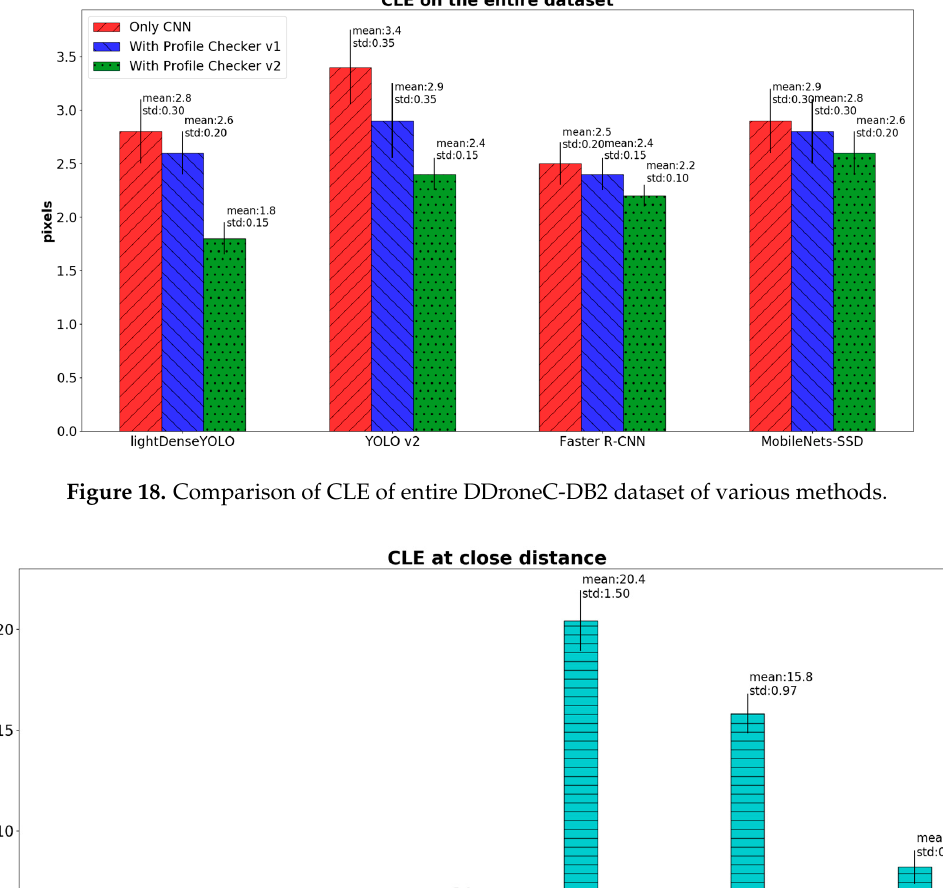
Figure 19. CLE comparison between our method and non-CNN marker trackers.